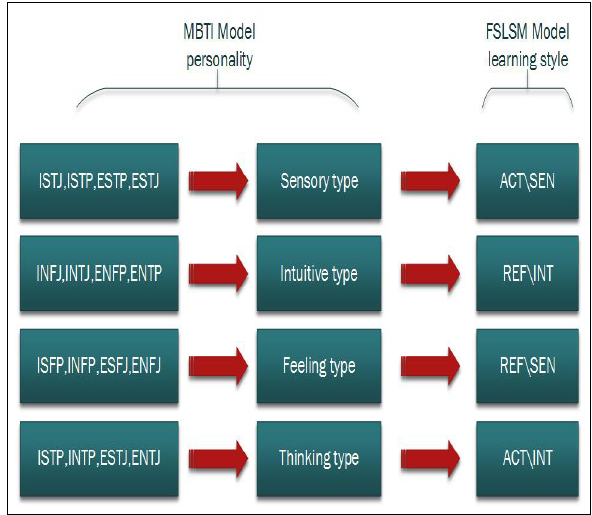
Figure 1. Matching the four Myers-Briggs Type Indicator dominant preferences with the Felder-Silverman